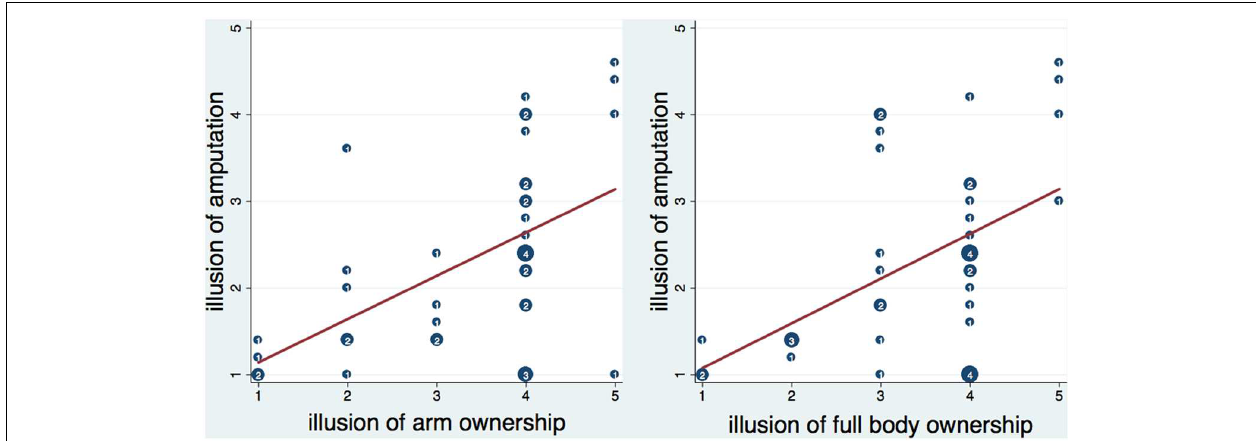
FIGURE 3 | Scatterplot of the amputation illusion with arm and full body ownership illusion. Numbers inside circles indicate the number of overlapping points and the red lines represent the fitted regression lines. The amputation illusion was significantly correlated with arm and full body ownership illusion (see text). Moreover, it was significantly predicted by arm ownership ( b = 0.49, t = 3.86, p < 0.001) and full body ownership ( b = 0.52, t = 3.52, p = 0.001) respectively. Both arm and full body ownership explained a significant proportion of variance in the amputation illusion [arm ownership – R 2 = 0.26, F ( 1 , 38 ) = 14.86, p < 0.001; full body ownership- R 2 = 0.23, F ( 1 , 38 ) = 12.42, p <